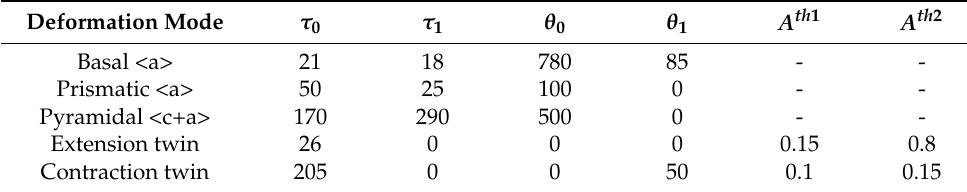
Table 1. Voce hardening parameters inputs for the VPSC modeling (unit: MPa).